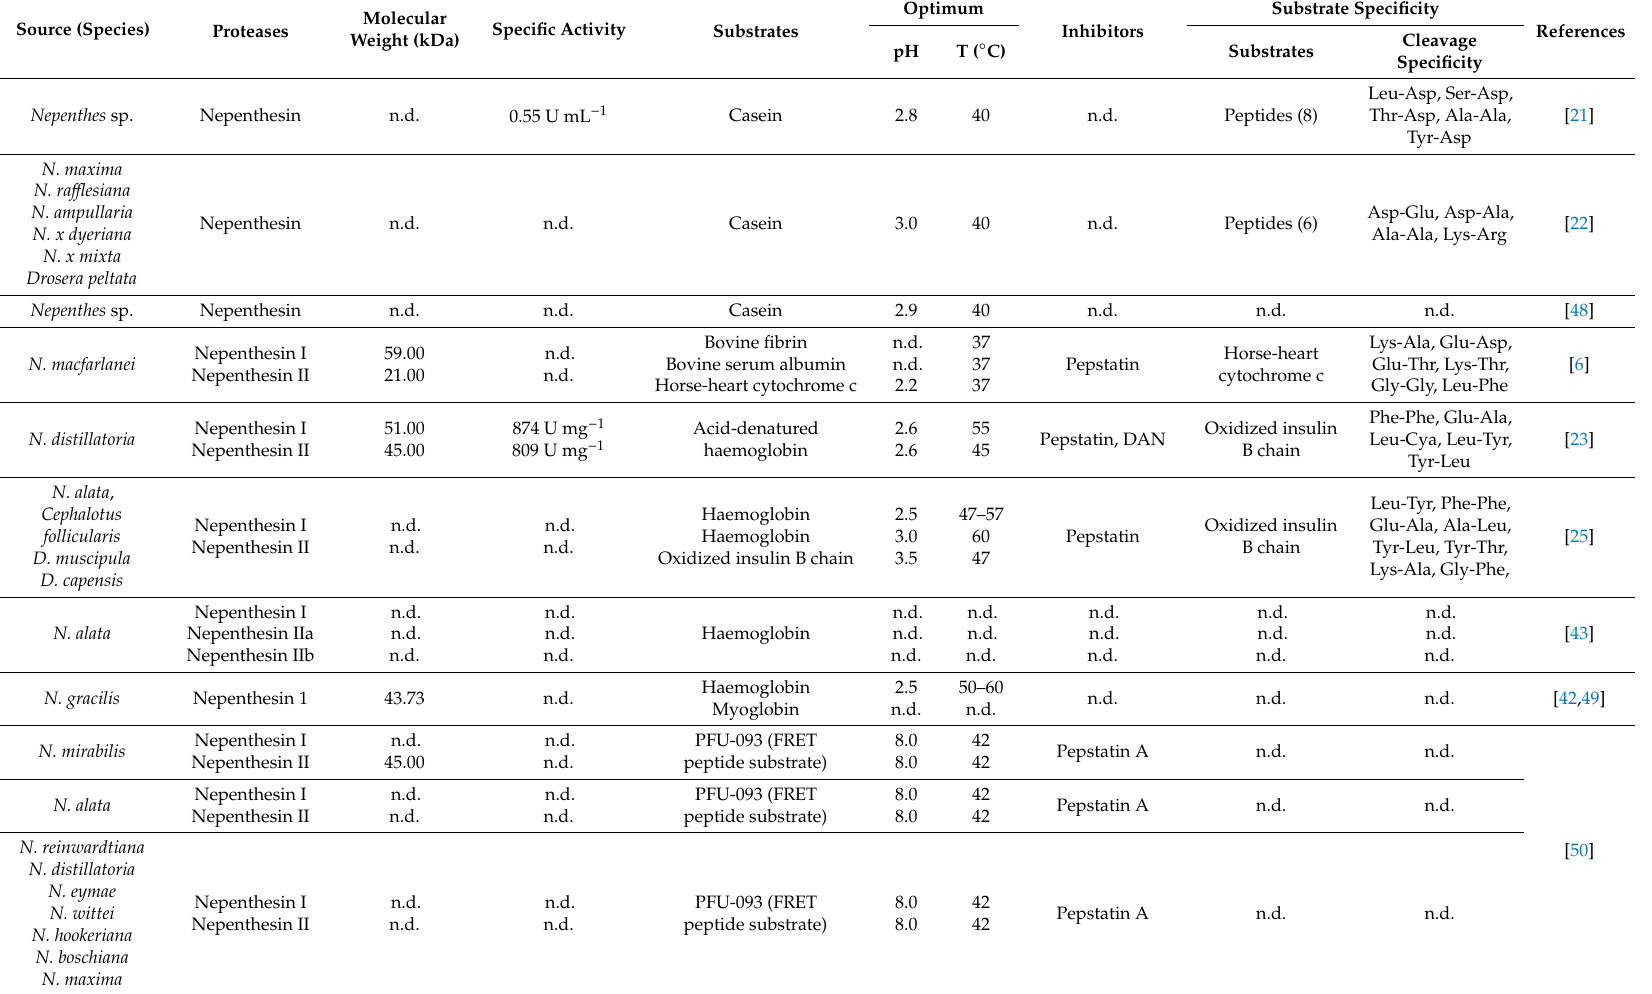
Table 1. Biochemical properties of nepenthesins from various carnivorous and crop